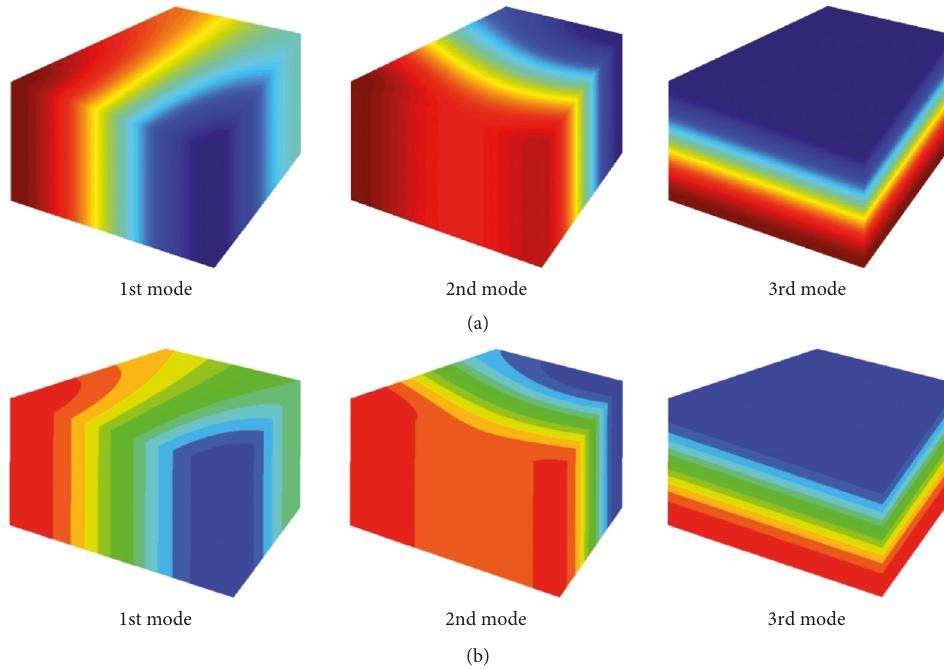
Figure 4: The first three modals of acoustic pressure distribution of the quadrangular prism acoustic cavity. (a) Present. (b) FEM. Table 5: The first eight natural frequencies (Hz) of the triangular prism acoustic cavity with various cavity depths. Mediums Depths